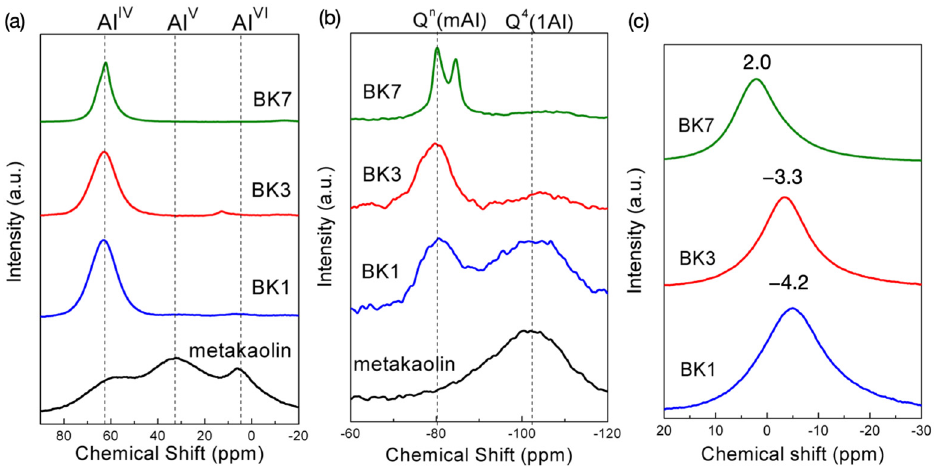
Figure 3. ( a ) 27 Al, ( b ) 29 Si, and ( c ) 23 Na NMR spectra of BK1, BK3, and